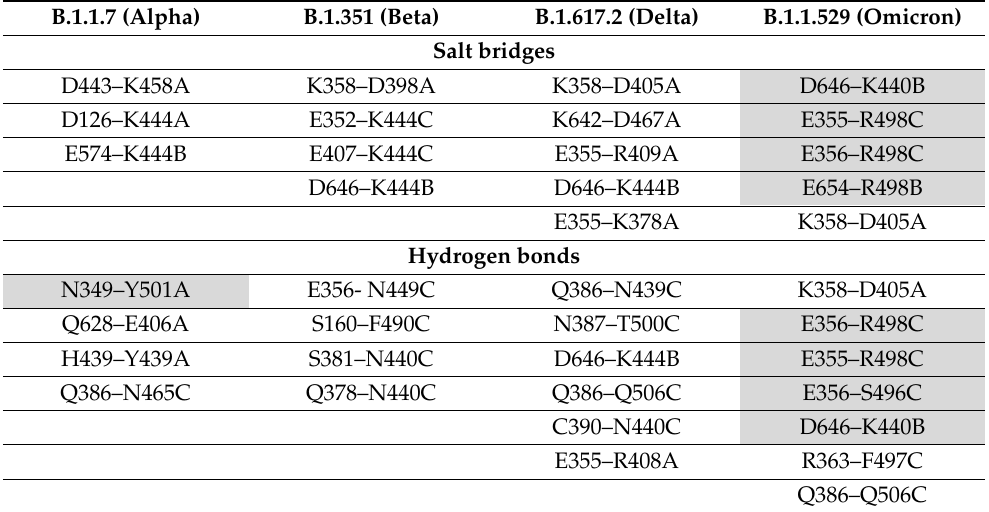
Table 4. Salt bridges and hydrogen bond interactions established between the bovine lactoferrin and the surface of the Spike glycoprotein (chain A, B or C), calculated for the four variants of concern. Only interactions identified for more than 40% of simulation time are shown. Residues highlighted in grey corresponds to variant-specific mutations.